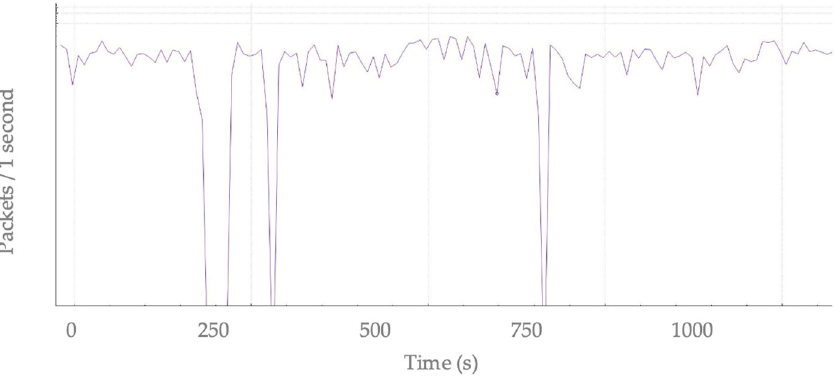
Figure 6. Device level Wireshark I/O graph (1000-s dataset) for normal data transmission environment.